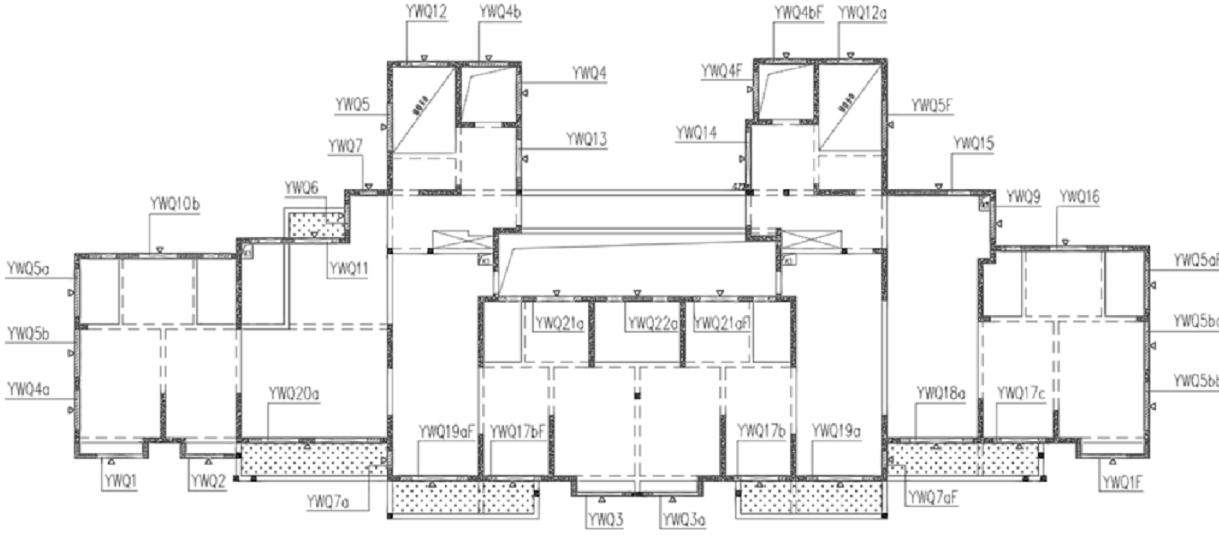
Figure 6. Plan of vertical prefabricated components of building #8. Building #8 is an assembly floor from the 5th floor onwards. The number of require- ments for each type of component and the weight of each component in building #8 are shown in Table 1. Table 1. Information table of prefabricated components demand for building #8 (13 floors, for ex- ample). Demand Point Serial Number